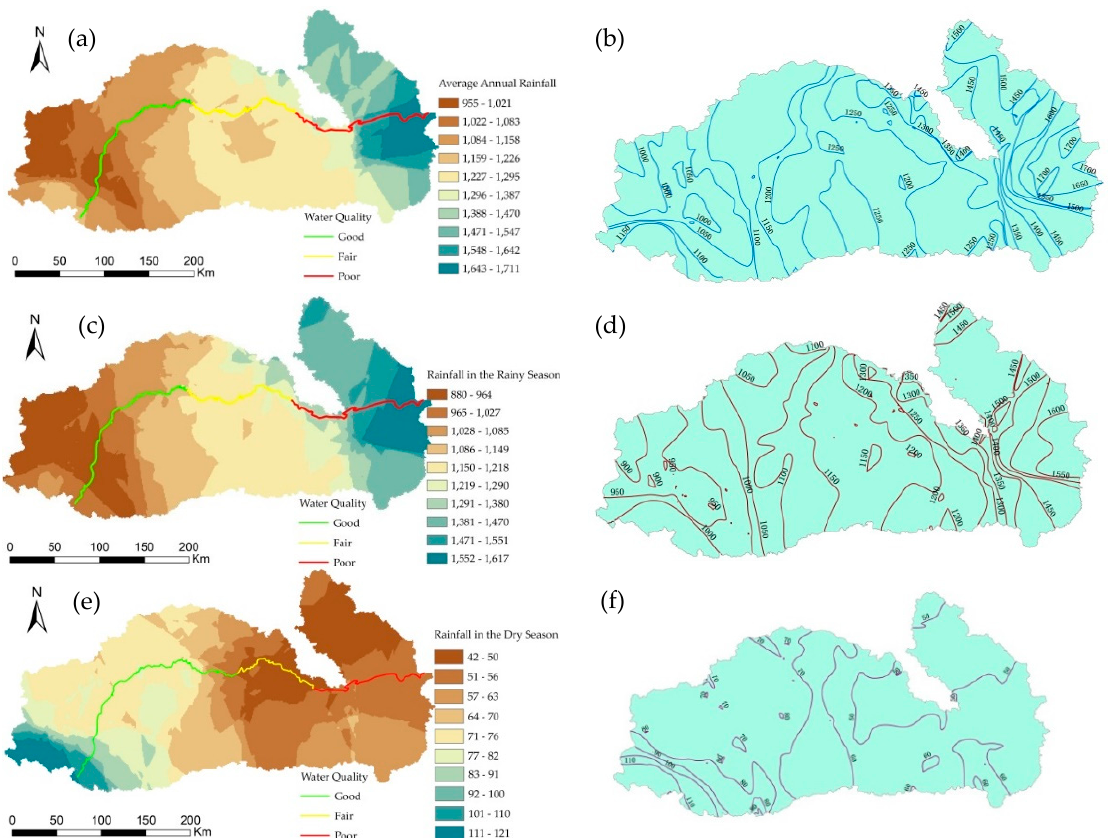
Figure 7. Spatial patterns of annual precipitation in the Mun River Basin. ( a ) is the map of average annual rainfall; ( b ) is the map of average annual rainfall contour; ( c ) is the map of rainfall in the rainy season; ( d ) is the map of rainfall contour in the rainy season; ( e ) is the map of rainfall in the dry season; ( f ) is the map of rainfall contour in the dry season.